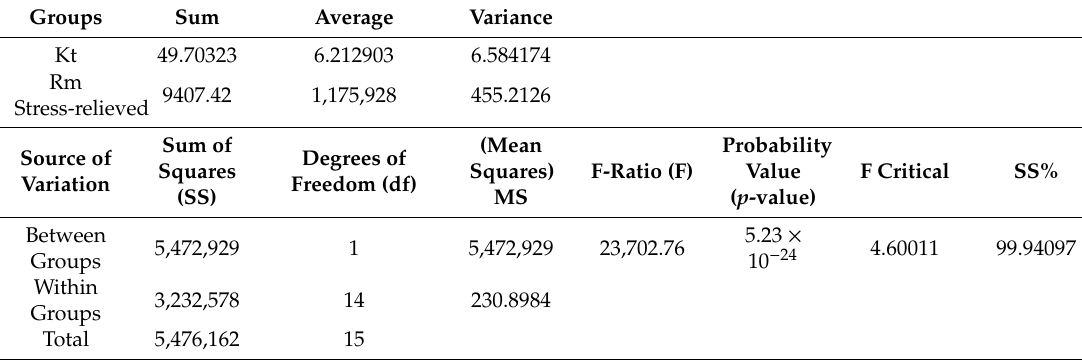
Table A9. ANOVA: Single Factor Stress-relieved.